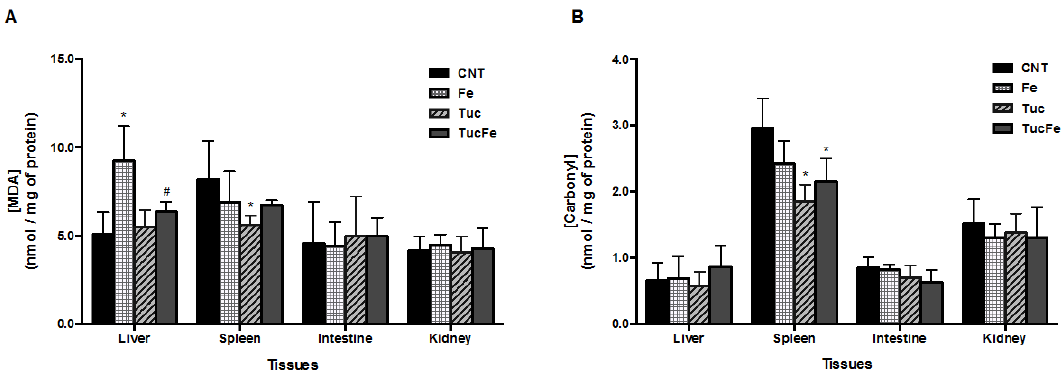
Figure 2. Levels of malondialdehyde (MDA) and carbonyl protein in the tissues, according to group treatment. CNT, Control group; Fe, iron-enriched group, Tuc, tucum-do-cerrado group; TucFe, tucum-do-cerrado iron-enriched group. Data are the means ± SD ( n = 6). Significant differences ( p < 0.05): * Comparison to the Control group; # Comparison to the Fe group.